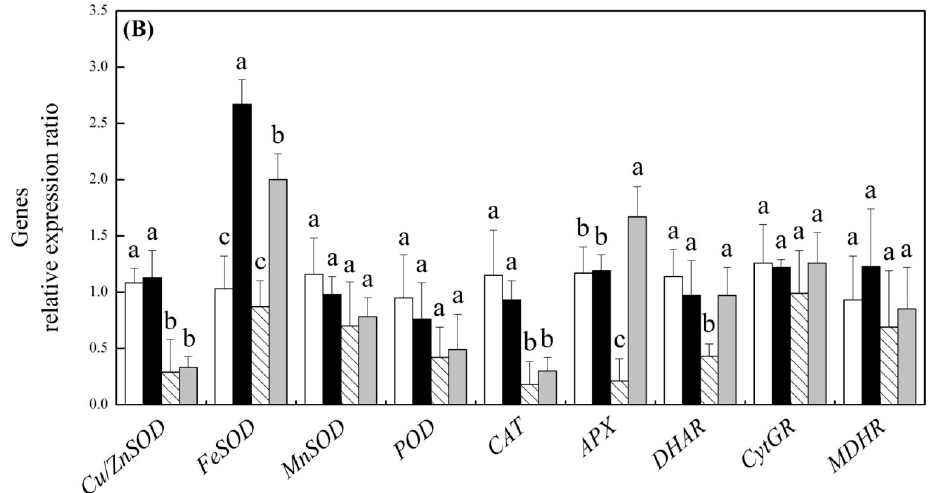
Figure 7. Effects of seeds soaking with water or NaCl (1 mM) on ( A ) antioxidant enzyme activities and ( B ) the relative expression ratio of genes encoding antioxidant enzymes after seven days of germination under normal conditions, and water stress induced by 19% polyethylene glycol (PEG) 6000. Vertical bars indicate ±SE of mean ( n = 6). Different letters above columns indicate significant difference ( p ≤ 0.05).